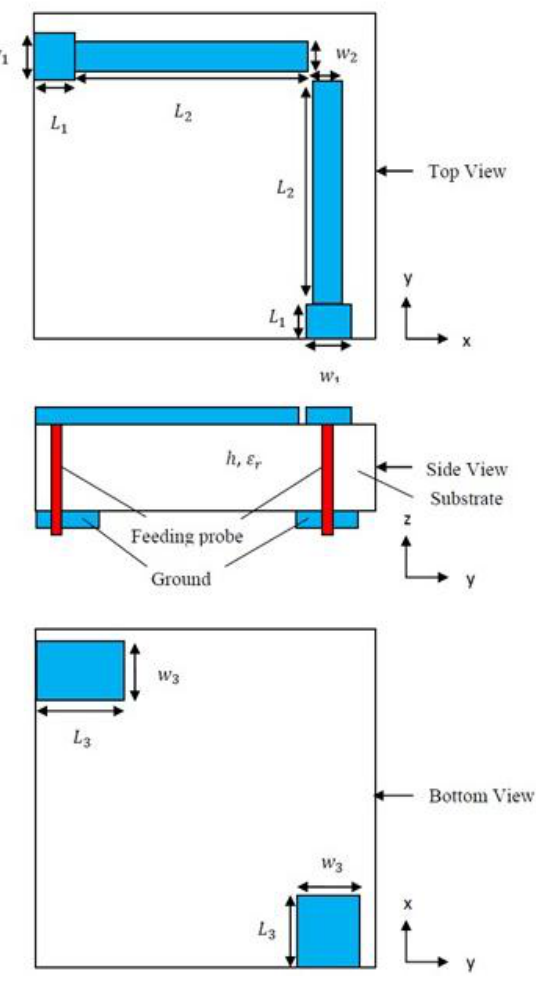
Fig. 1 : Geometry of the antenna.